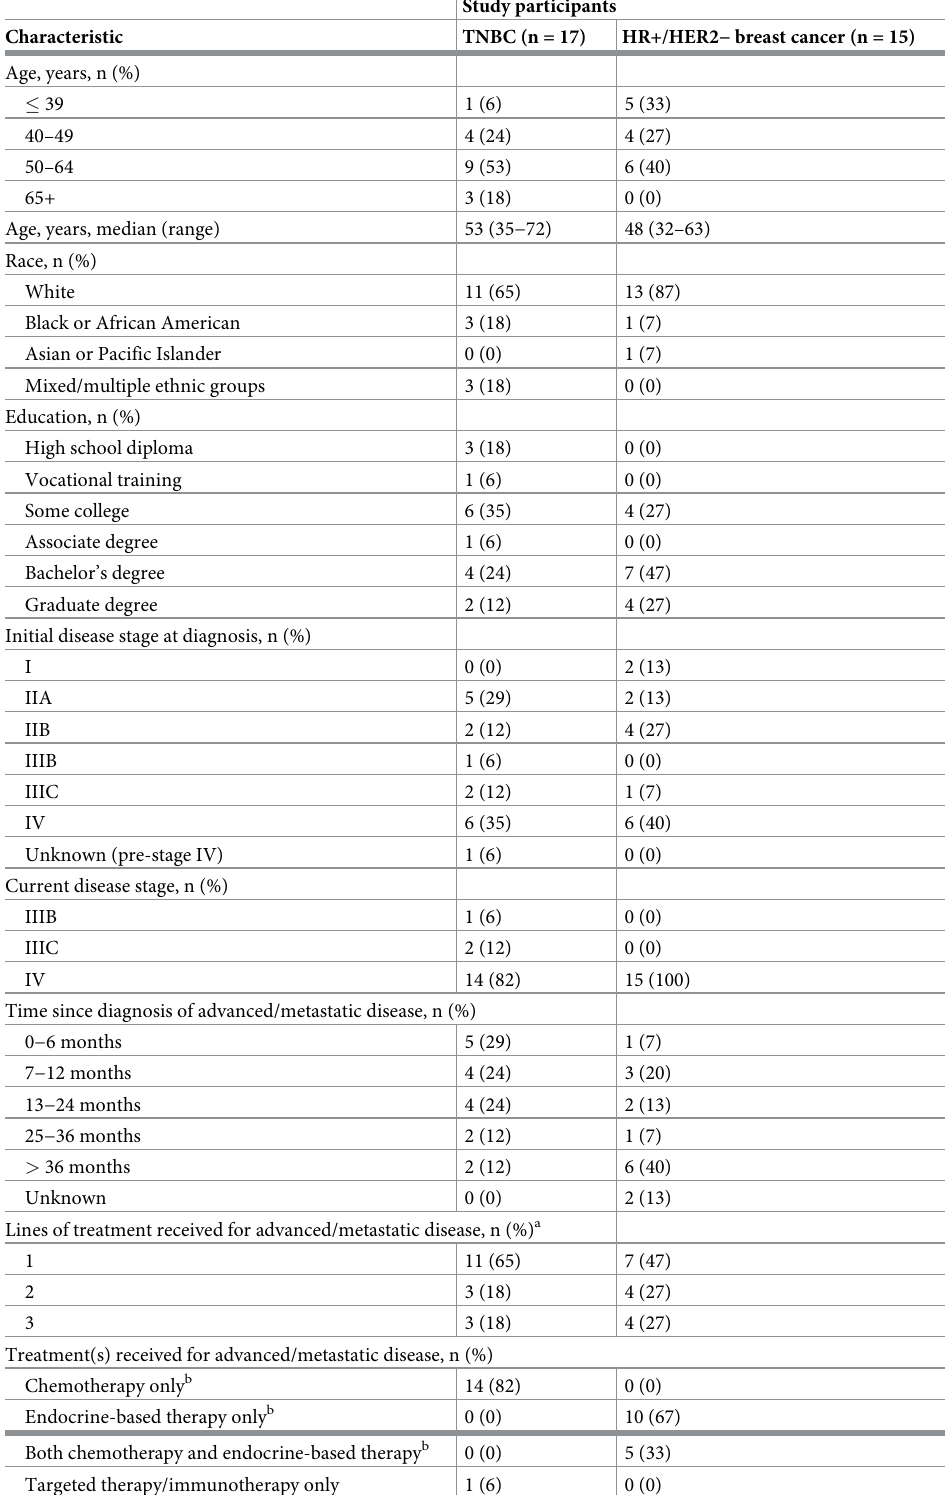
Table 1. Demographic and clinical characteristics of study